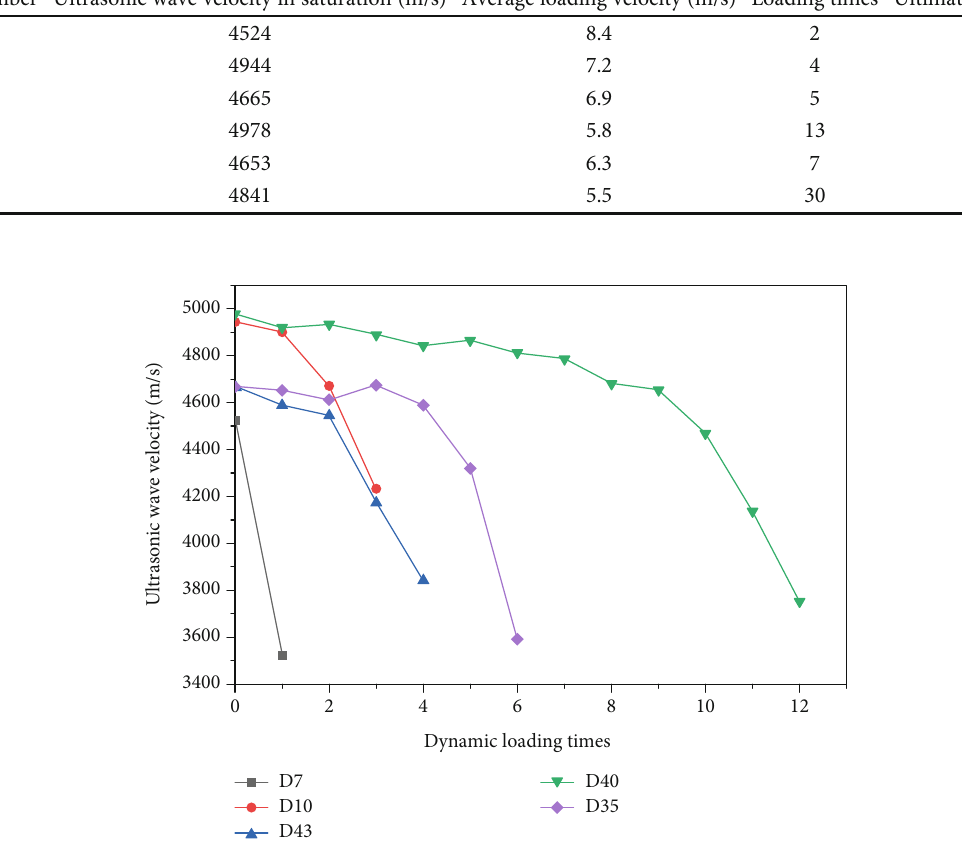
Figure 12: Relationship between the dynamic loading times and the ultrasonic wave